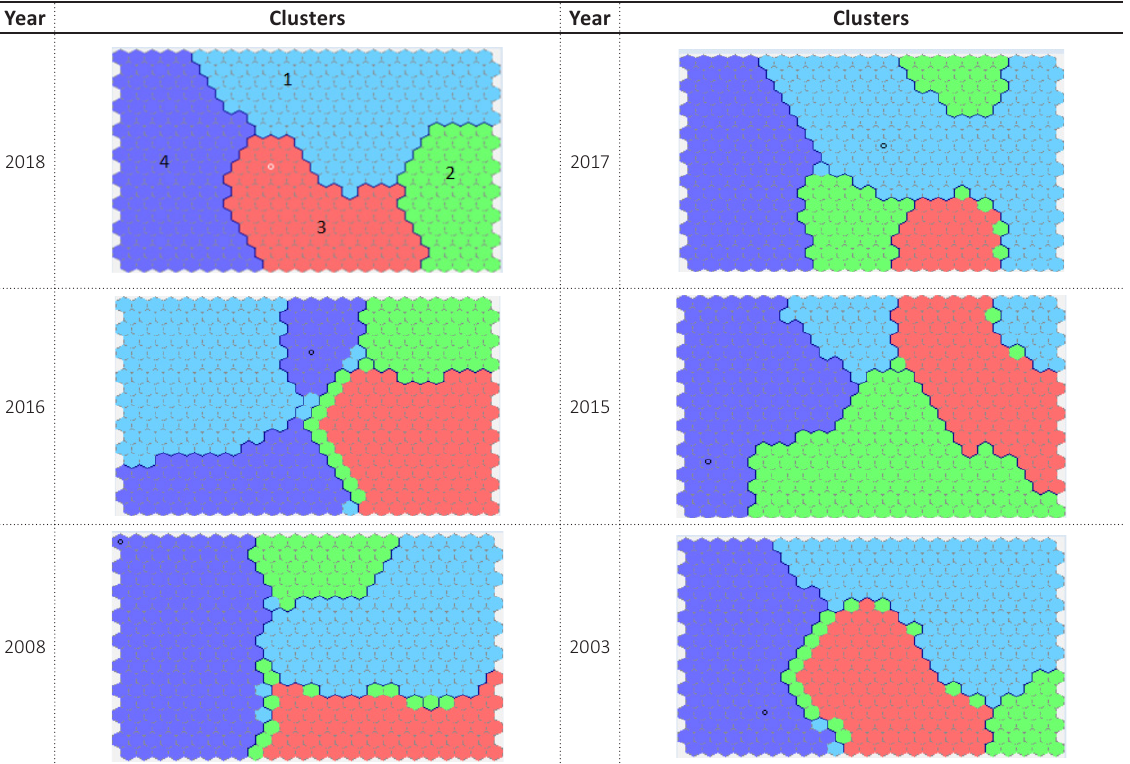
tween investment potential with and without technology is only increasing every year.